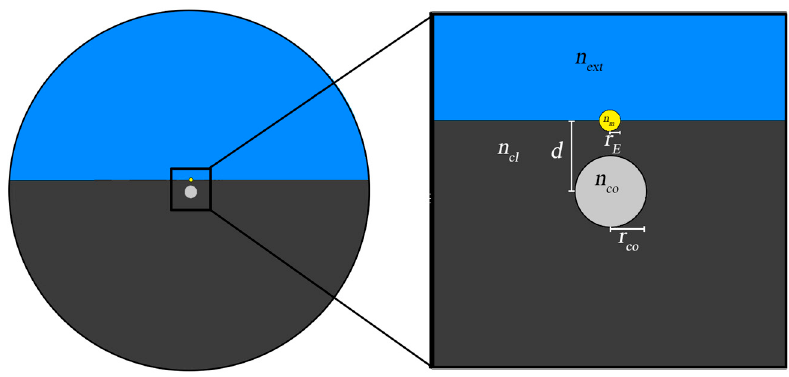
Figure4. D-typefiberconfigurationwithmetallicnanowire, Figure 4. D-type fiber configuration with metallic nanowire, with a close-up inset of the relevant features.